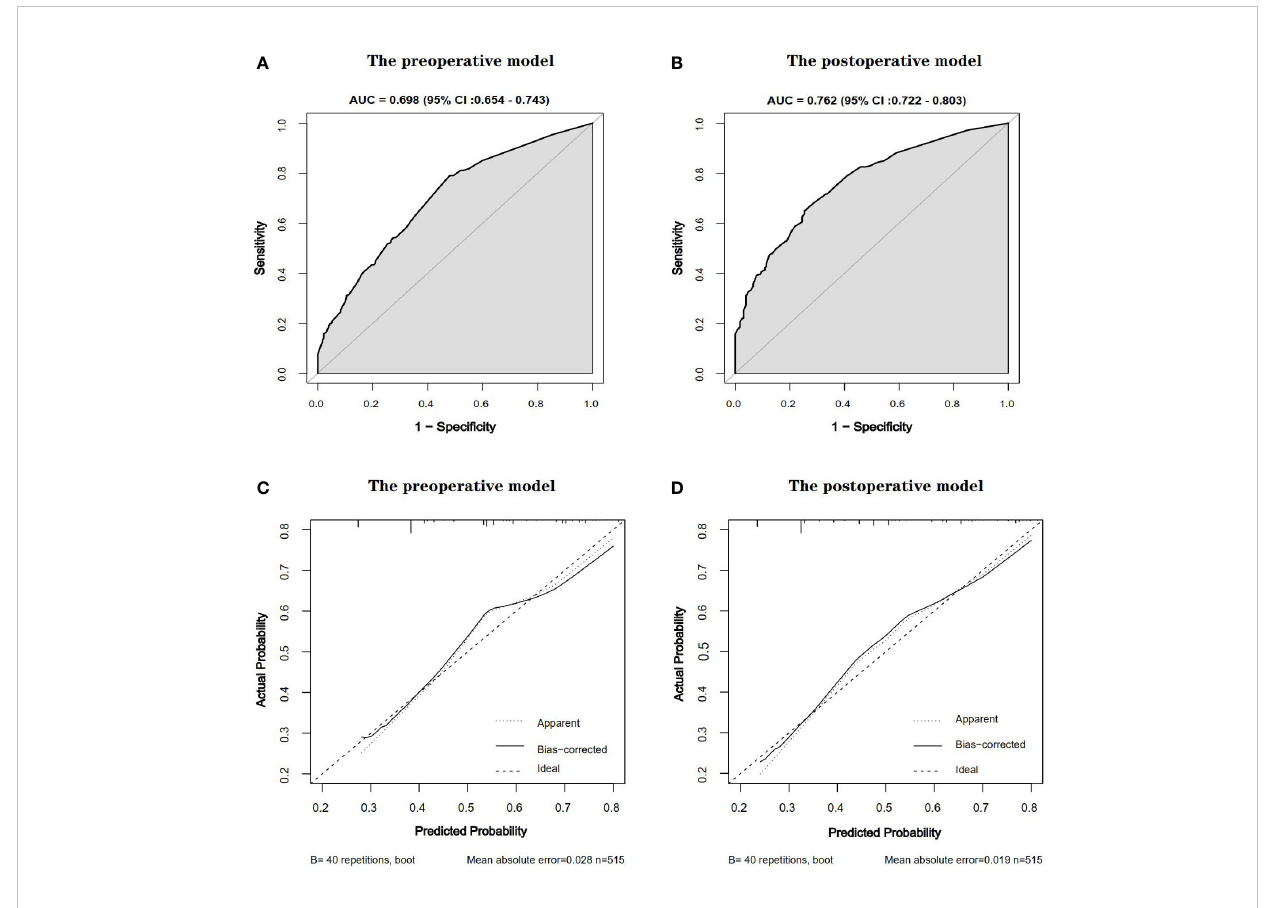
results with actual results. The dotted line is the reference line, indicating the position of the ideal nomogram. The solid line represents the bootstrap performance of 40 samples of the nomogram. When the predicted probability is plotted against the actual probability, the calibration plot is close to the dotted line, indicating that the calibration plot for the nomogram is good in both groups. AUC, area under the curve; CI, con fi dence